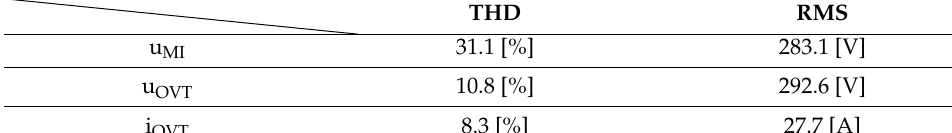
Figure 5. The voltage and current waveforms ( a ) for the OVT inverter under a resistive load and their spectra ( b ). Table 2. Selected voltage and current parameters for inverter MI and OVT.